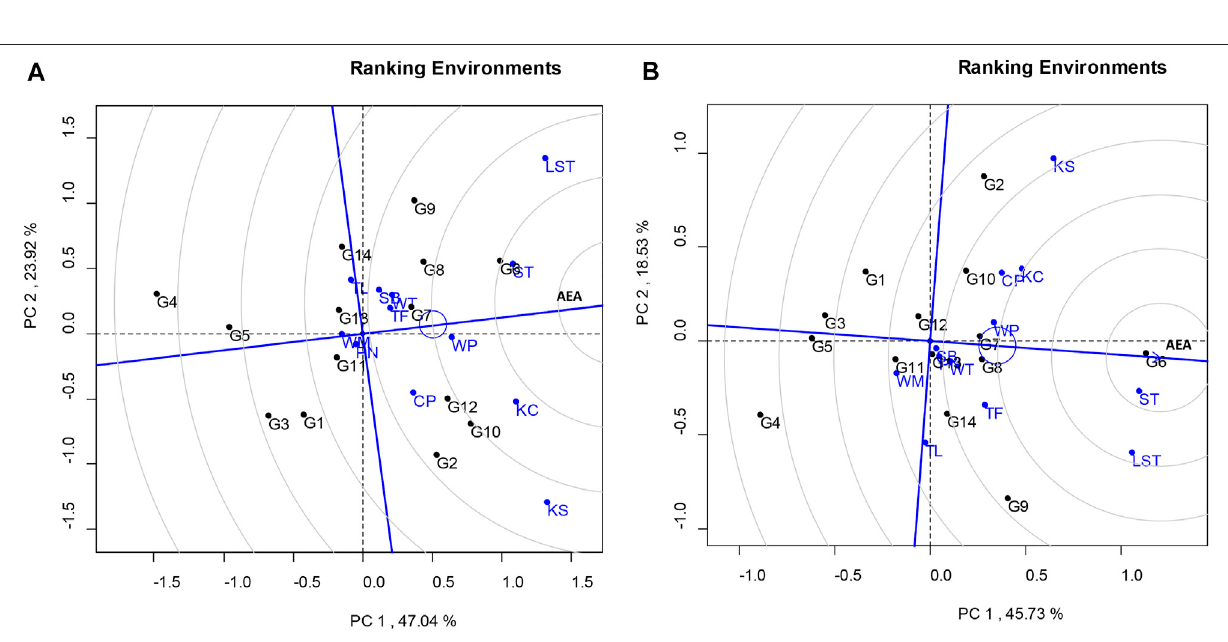
Frontiers in Genetics |